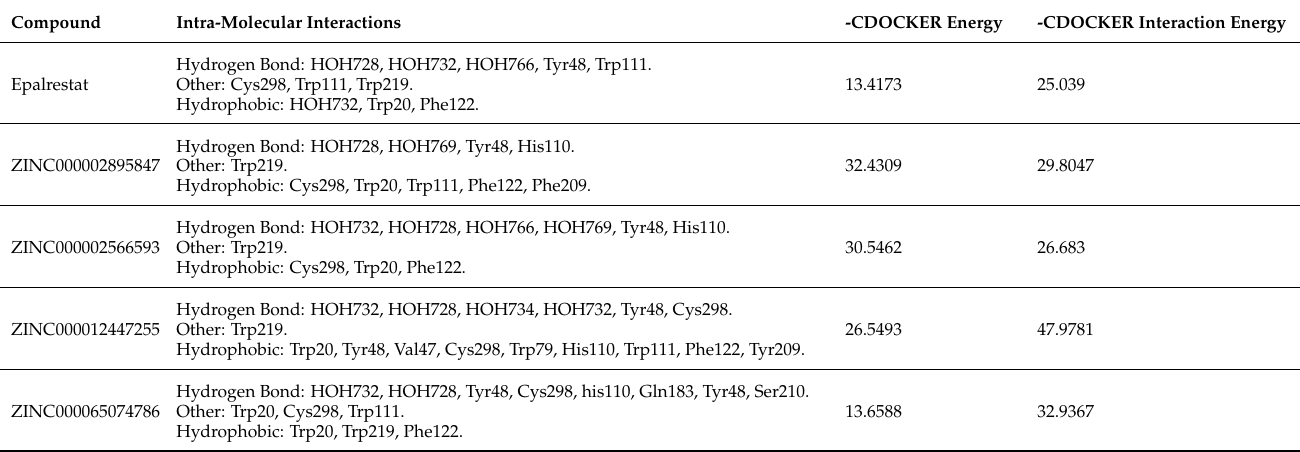
Table 6. Close intra-molecular interaction of the top pharmacophores and